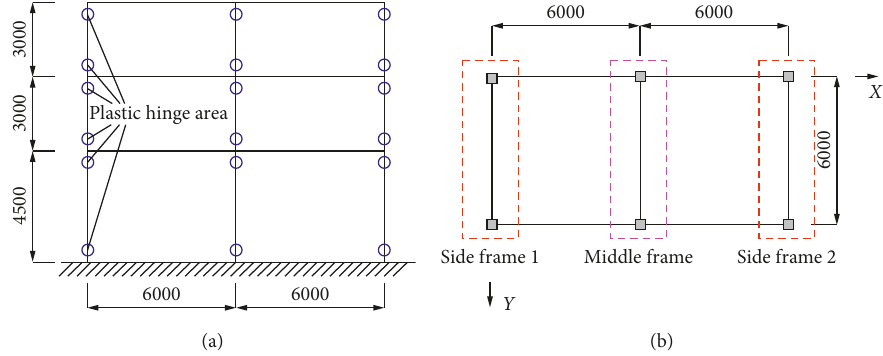
Figure 1: (a) Floor plan of the poorly designed RC building. (b) Layout of columns.